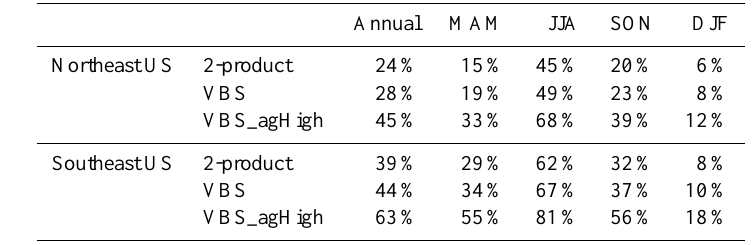
Table 4. Fraction of SOC in total OC (%) in the southeast US and the northeast US.